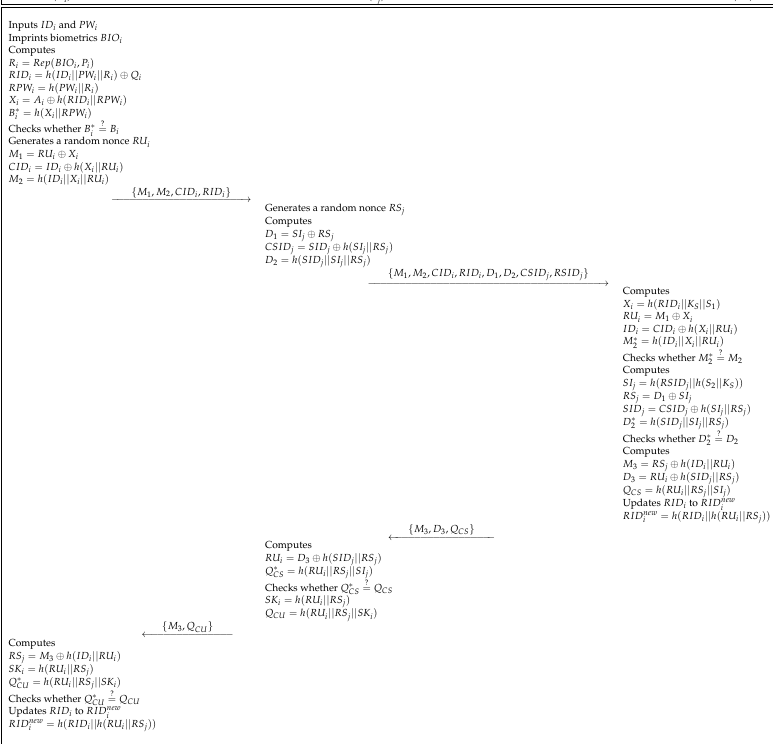
Figure 7. Login and authentication process of the proposed